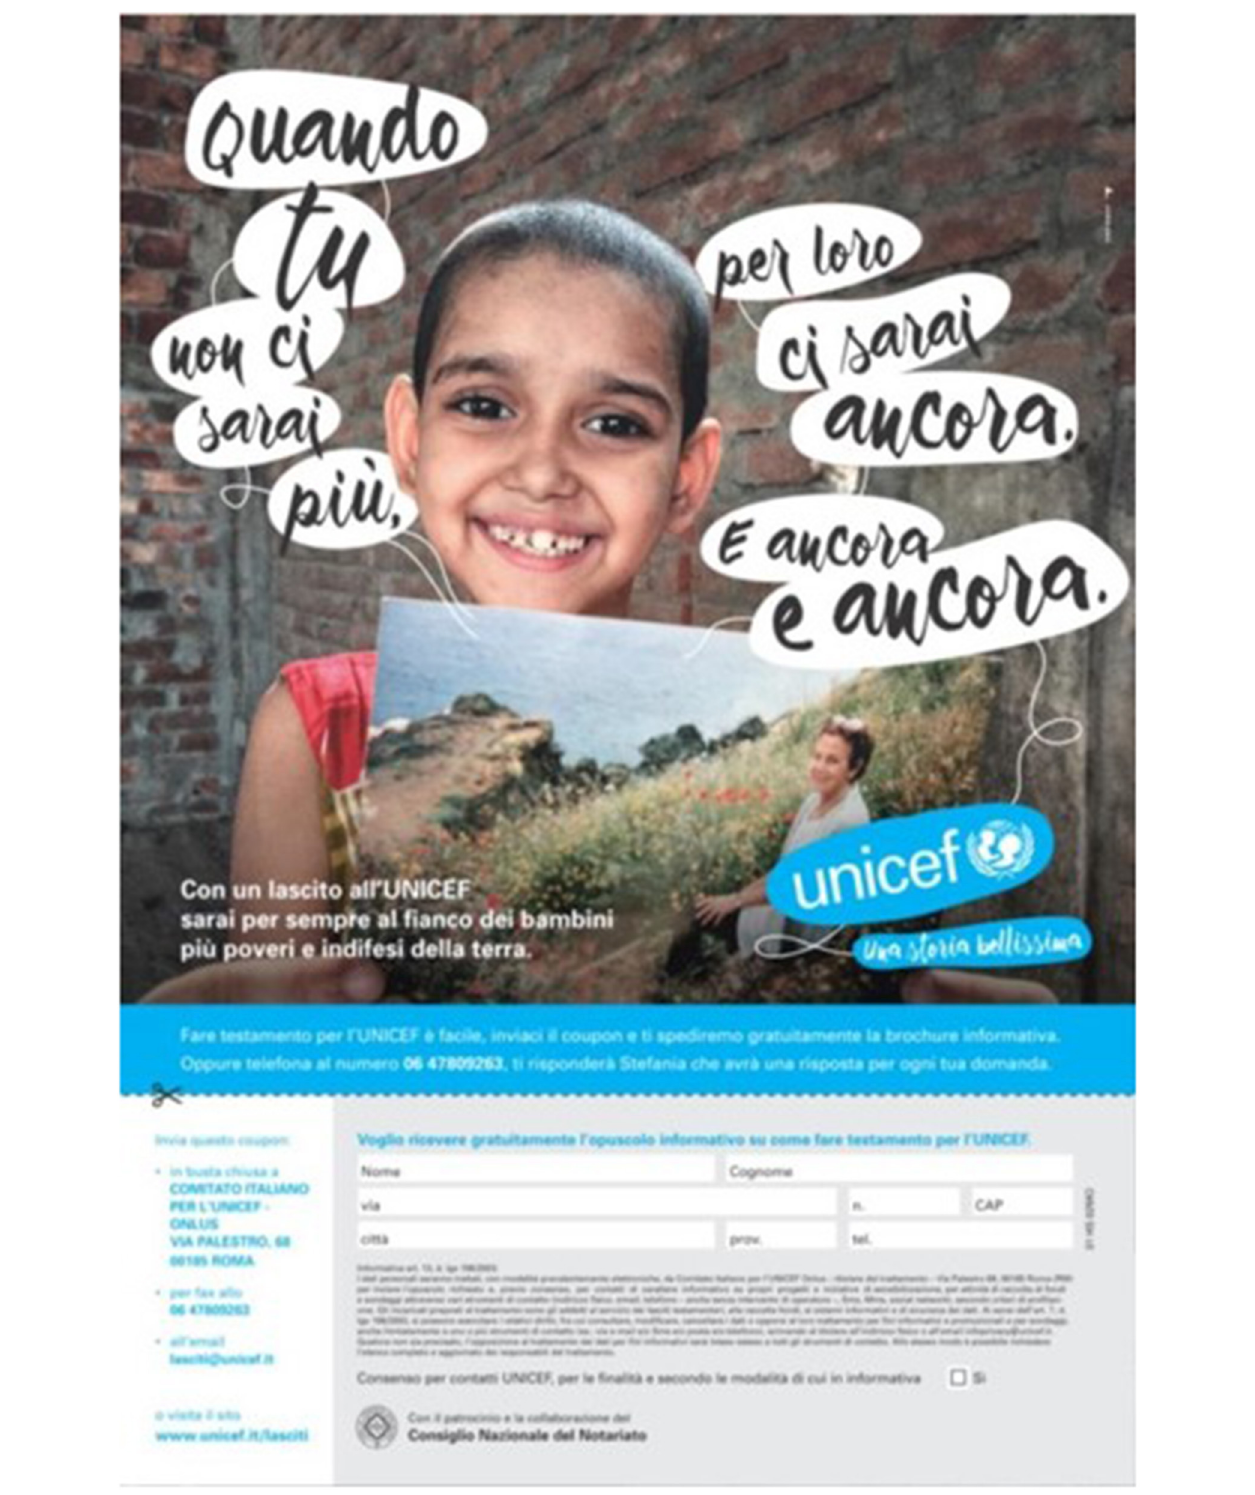
FIGURE 4 | Unicef Flyer B. Source: Unicef Italia Donare un lascito testamentario (2018).